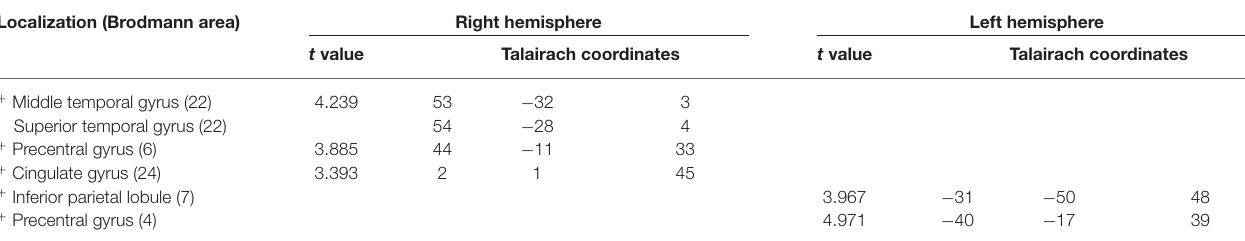
TABLE 2 | Results of paired sample t -test post- minus pre-treatment within group. Localization (Brodmann area) Right hemisphere Left hemisphere t value Talairach coordinates t value Talairach coordinates + Middle temporal gyrus (22) 4.239 53 −